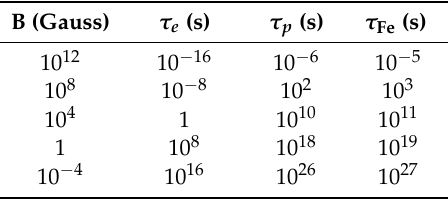
Table 1. Typical cooling times of electrons τ e , protons τ p and fully ionized iron nucleus τ Fe for various values of magnetic field strength B